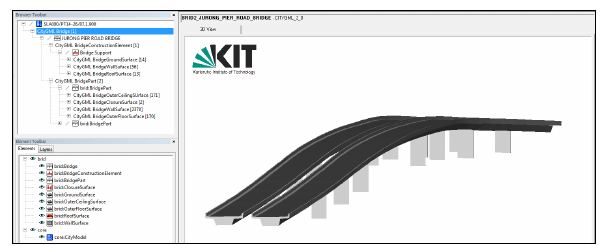
Figure 9. A sample of LOD 2 Road